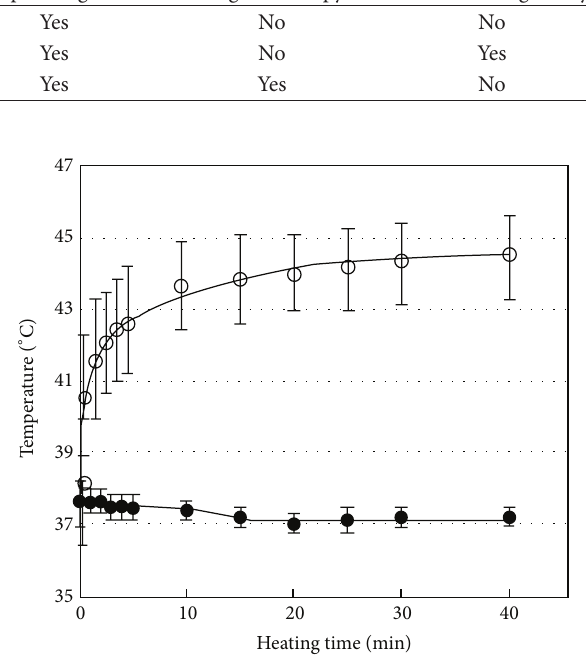
Figure 20: The difference of temperature increasing between target tissue, which is containing Fe 3 O 4 particles (marked with solid circles), and another one, without these particles (marked with hollow circles). Based on this figure, the presence of magnetic particles causes targeted hyperthermia